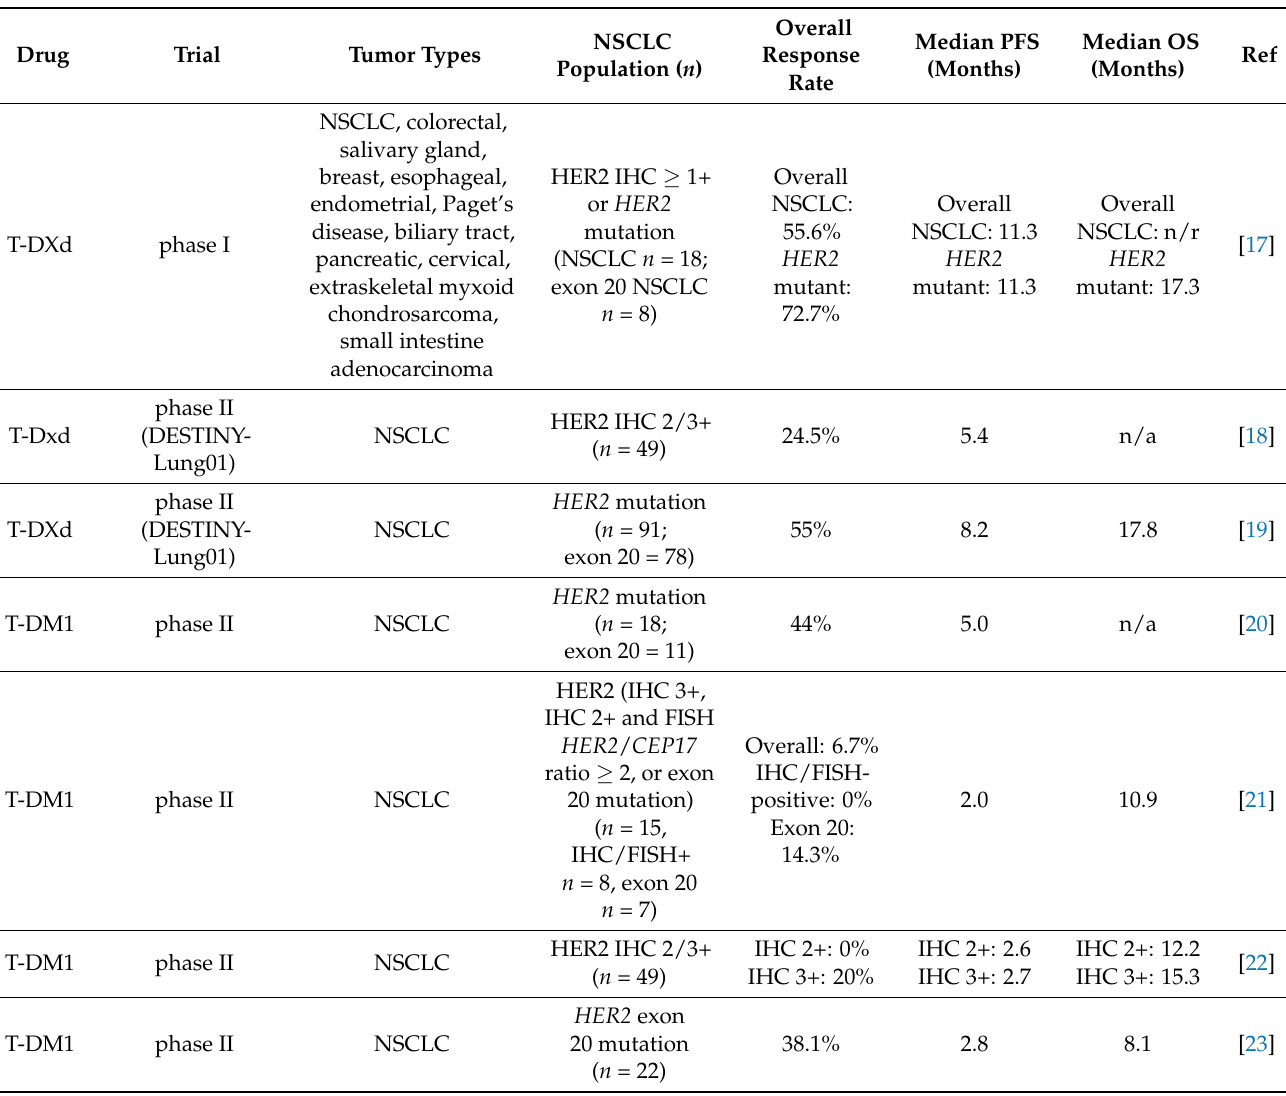
Table 1. Studies of Antibody Drug Conjugates in HER2 altered